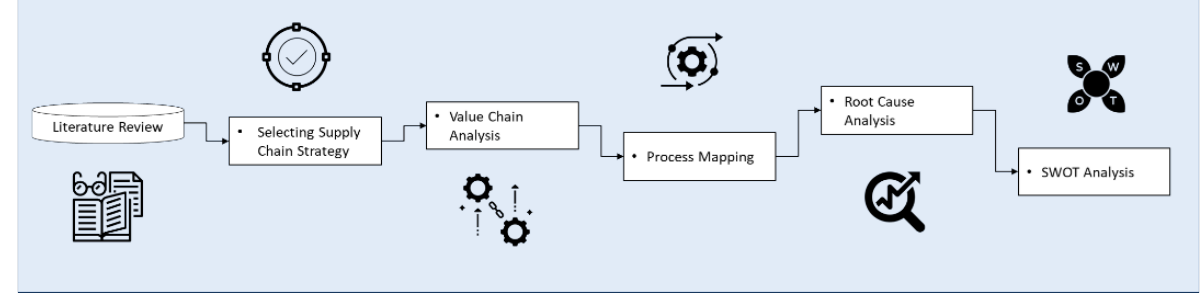
Figure 1. SCA methodological steps. Source: [13].